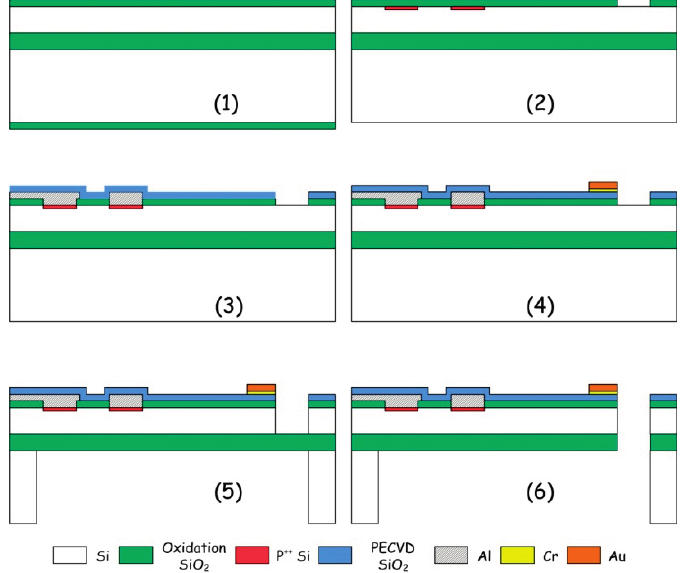
Figure 3. Micromachining fabrication processes of the integrated resonant micro-cantilever. Reprinted with permission from [48].